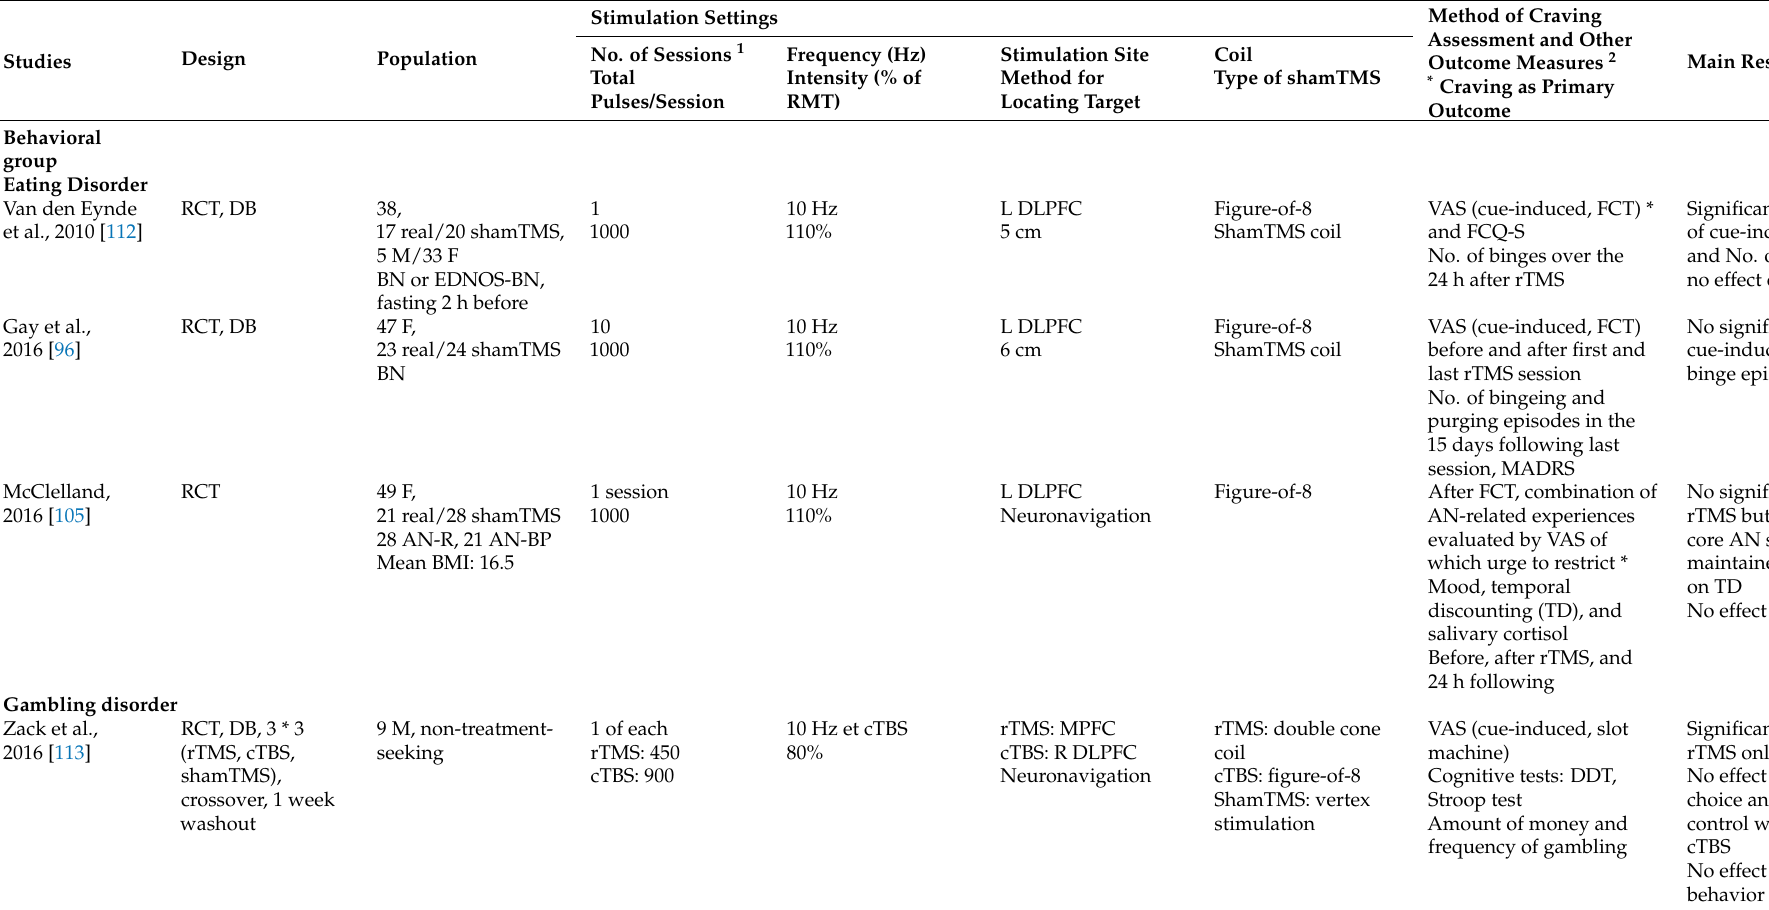
VAS (cue-induced, FCT) * and FCQ-S No. of binges over the 24 h after rTMS VAS (cue-induced, FCT) before and after first and last rTMS session No. of bingeing and purging episodes in the 15 days following last session, MADRS After FCT, combination of AN-related experiences evaluated by VAS of which urge to restrict * Mood, temporal discounting (TD), and salivary cortisol Before, after rTMS, and 24 h following VAS (cue-induced, slot machine) Cognitive tests: DDT, Stroop test Amount of money and frequency of